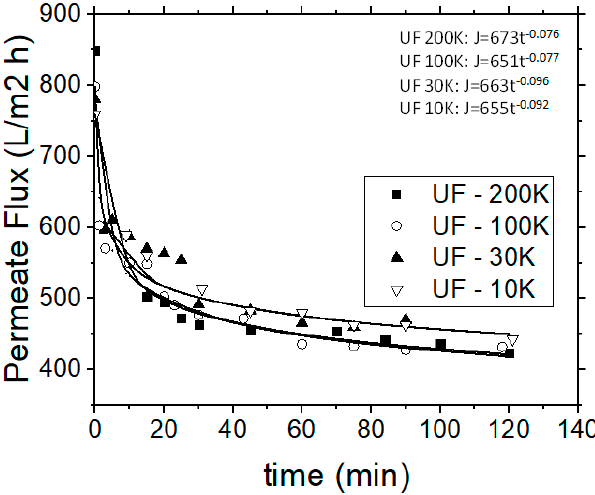
Figure 6. Permeate flow rate variation vs. operational time for the UF process.